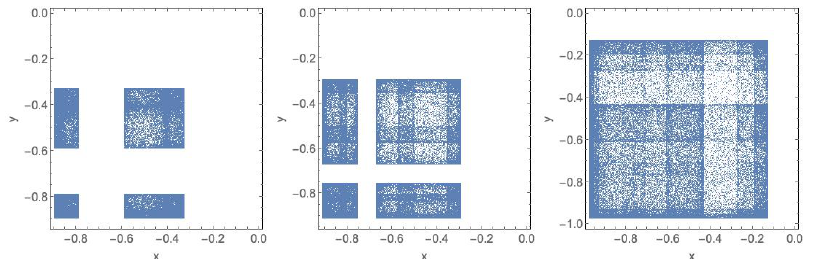
Figure 22. ω -limit sets for µ = 1.56, µ = 1.58 and µ = 1.66 (left, center and right respectively) and initial conditions x 0 = − 0.5 and y 0 = − 0.3.